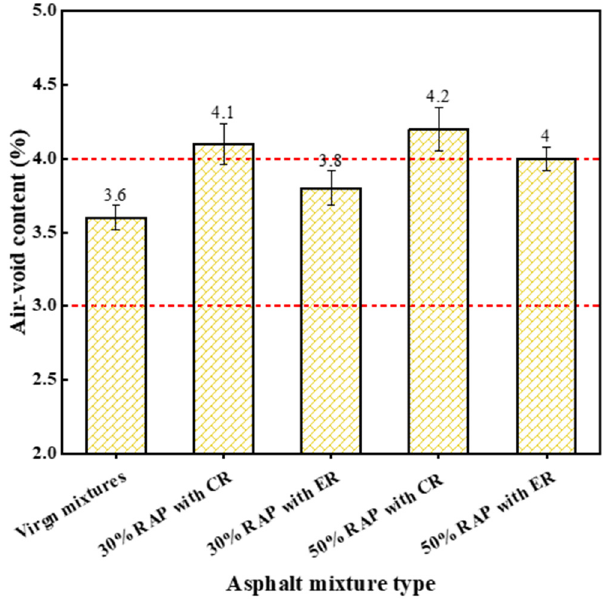
Figure 6. Air void content of each studied mixture.